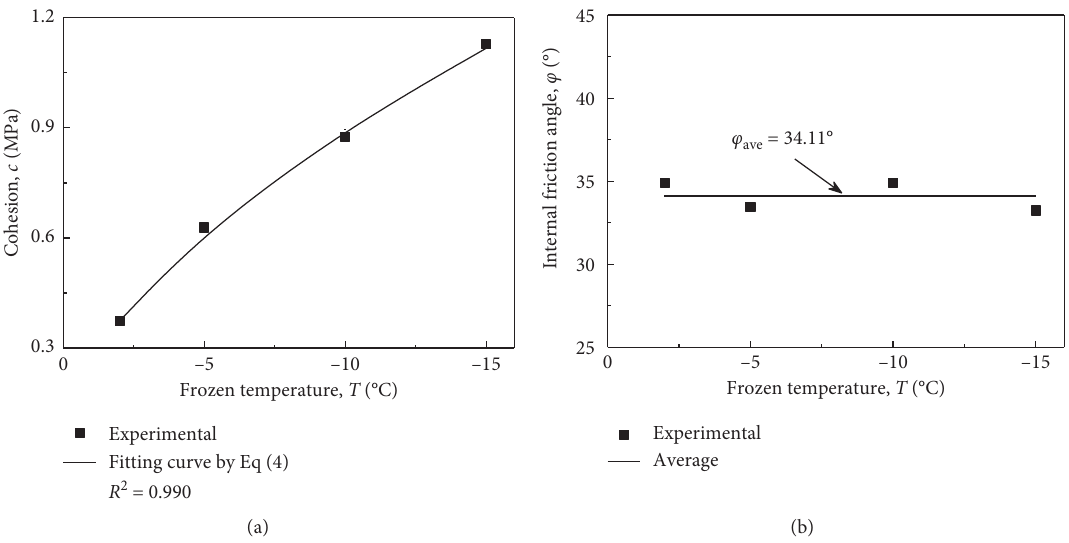
Figure 7: Variation of (a) cohesion and (b) internal friction angle versus frozen temperature.